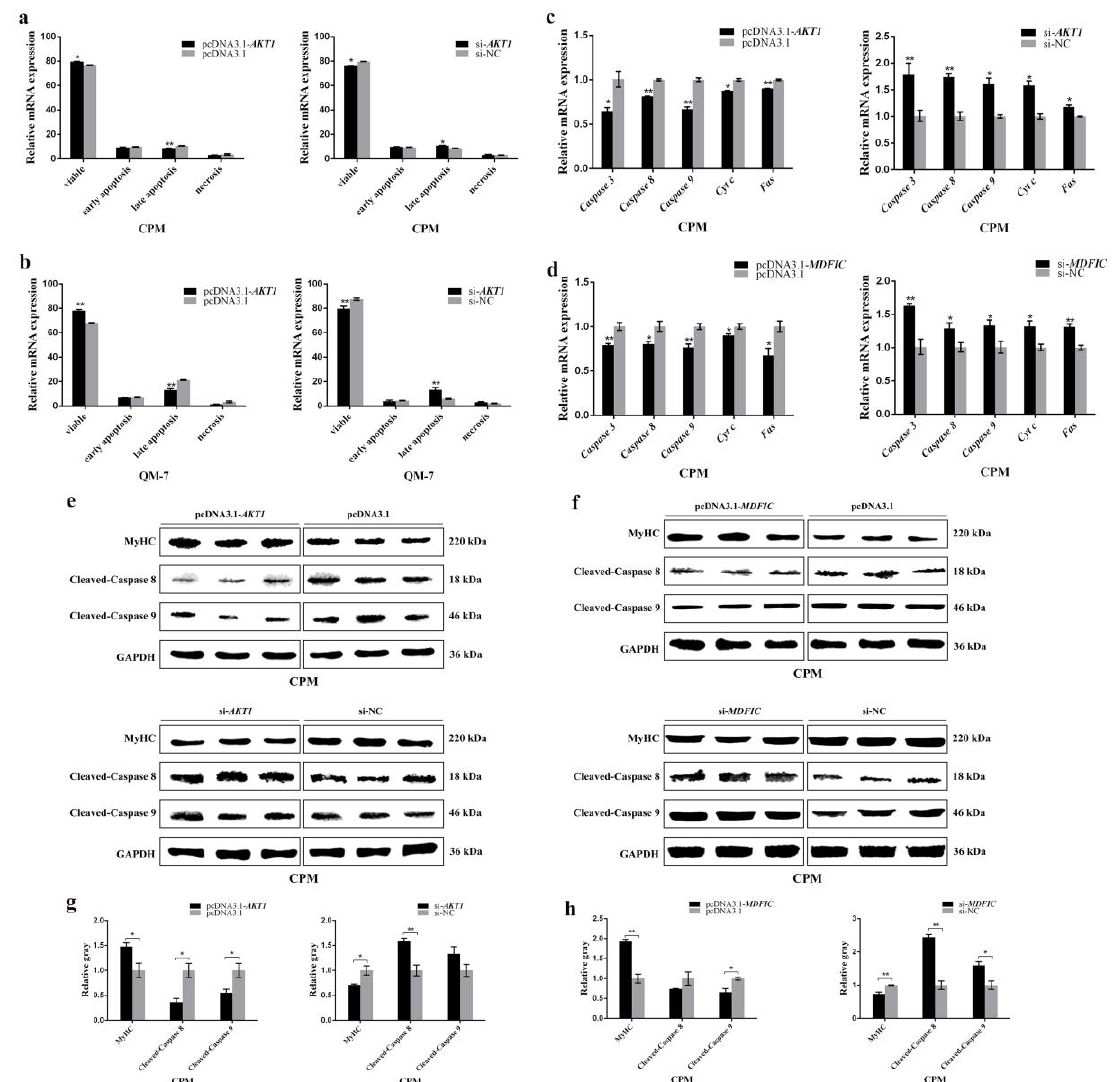
Figure 7 . AKT1 shows an inhibitory effect on myoblast apoptosis and so does MDFIC. ( a , b ) Flow cytometry analysis of Annexin V-FITC and PI dual staining detecting the apoptosis of CPMs after transfection of pcDNA3.1- AKT1 or si- AKT1 . ( c ) Relative mRNA expression of the cell apoptosis-related genes after transfection of pcDNA3.1- AKT1 or si- AKT1 in CPMs. ( d ) Relative mRNA expression of the cell apoptosis-related genes after transfection of pcDNA3.1- MDFIC or si- MDFIC in CPMs. ( e , f ) The protein levels of MyHC, cleaved-caspase 8, and cleaved-caspase 9 after the overexpression or silence of AKT1 and MDFIC in CPMs. ( g , h ) Gray value analysis of protein bands in ( e , f ). Results of all groups are shown as mean ± S.E.M. of three independent assessment methods. Statistical significance of the mean di ff erence was assessed using unpaired two-sample t -tests. * p < 0.05; ** p < 0.01. NC, negative